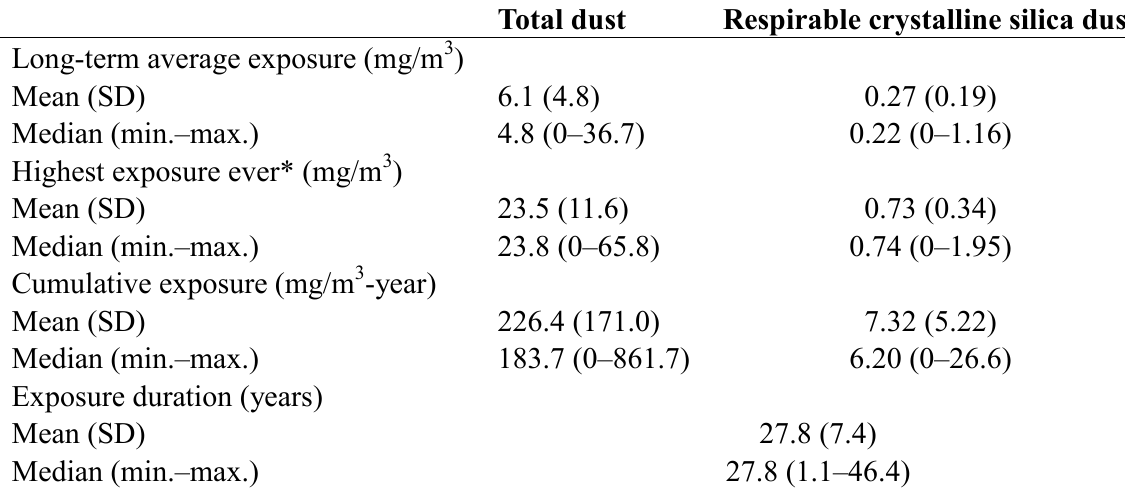
Table 2. Description of dust